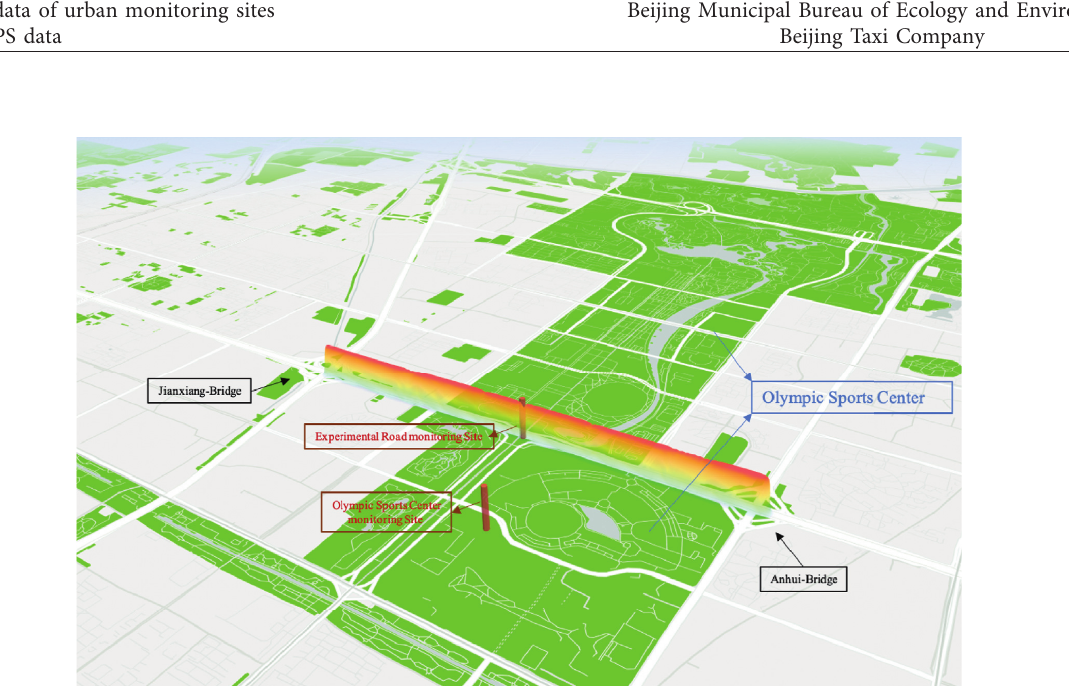
Figure 12: The location of experimental road, road monitoring site, and Olympic Sports Center monitoring